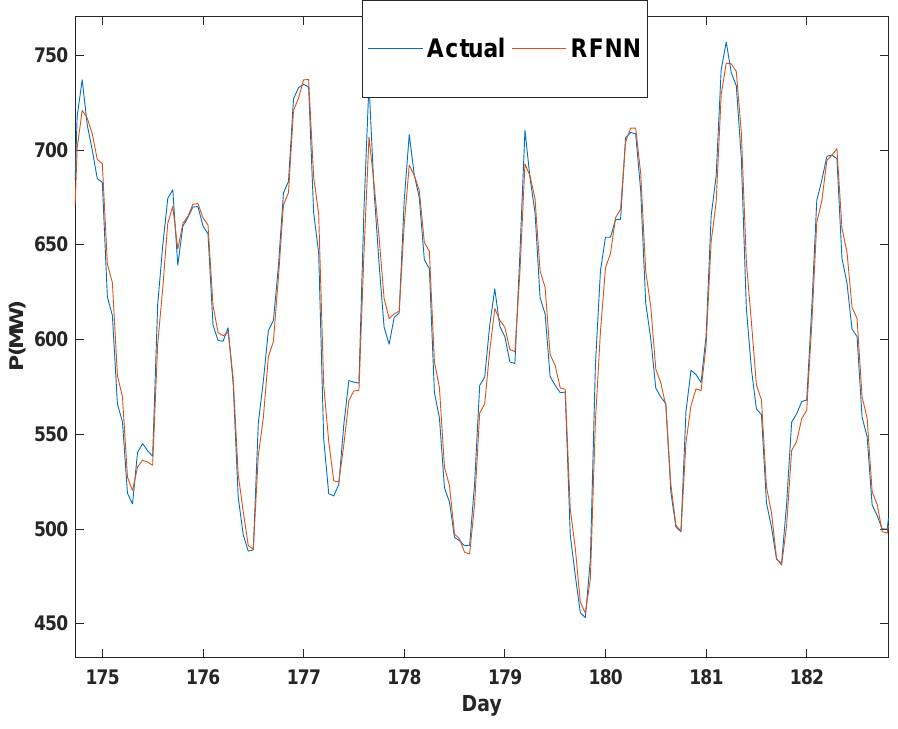
Figure 10. Zoom in to Figure 8. (Days 175 to